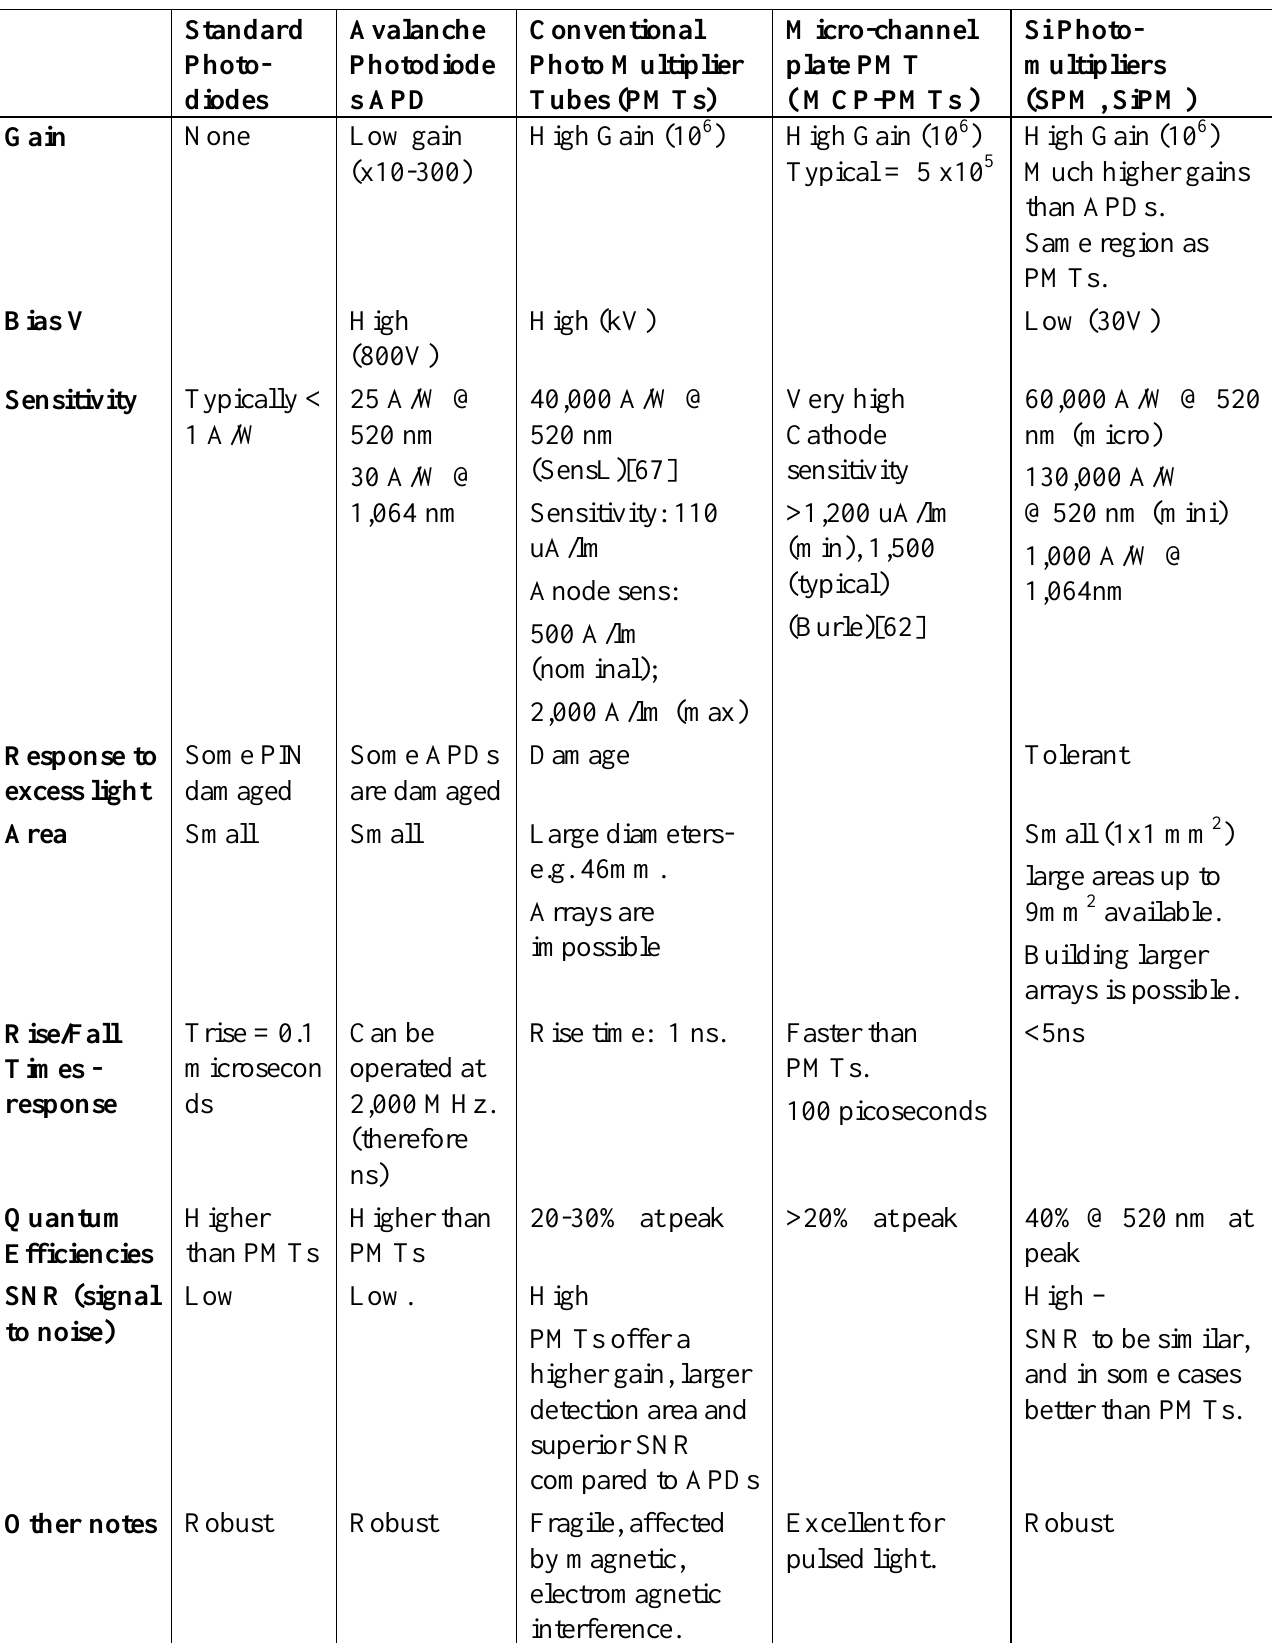
Table 8. Comparison of different light